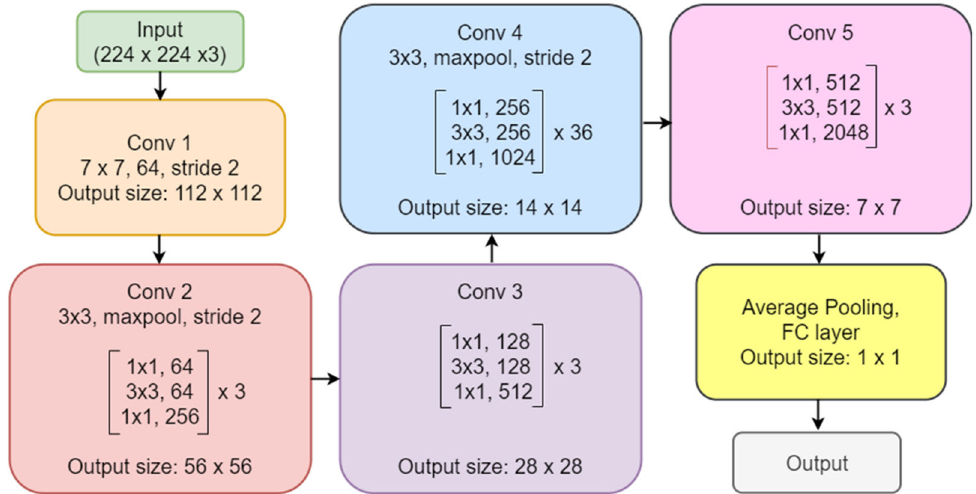
Figure 11. ResNet50 architecture.